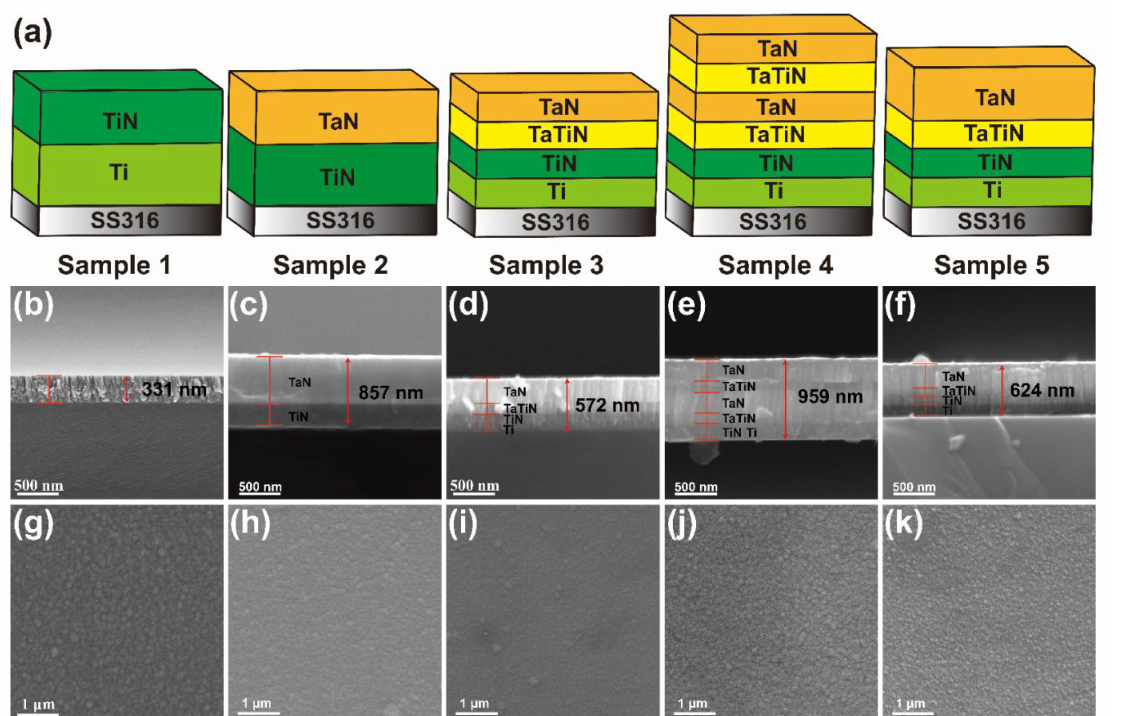
Figure 1. Structural and compositional characterizations of coatings. ( a ) Design of coating structures (not to scale). Cross-sectional SEM images of ( b ) Sample 1, ( c ) Sample 2, ( d ) Sample 3, ( e ) Sample 4, and ( f ) Sample 5. Surface morphology SEM images of ( g ) Sample 1, ( h ) Sample 2, ( i ) Sample 3, ( j ) Sample 4, and ( k ) Sample